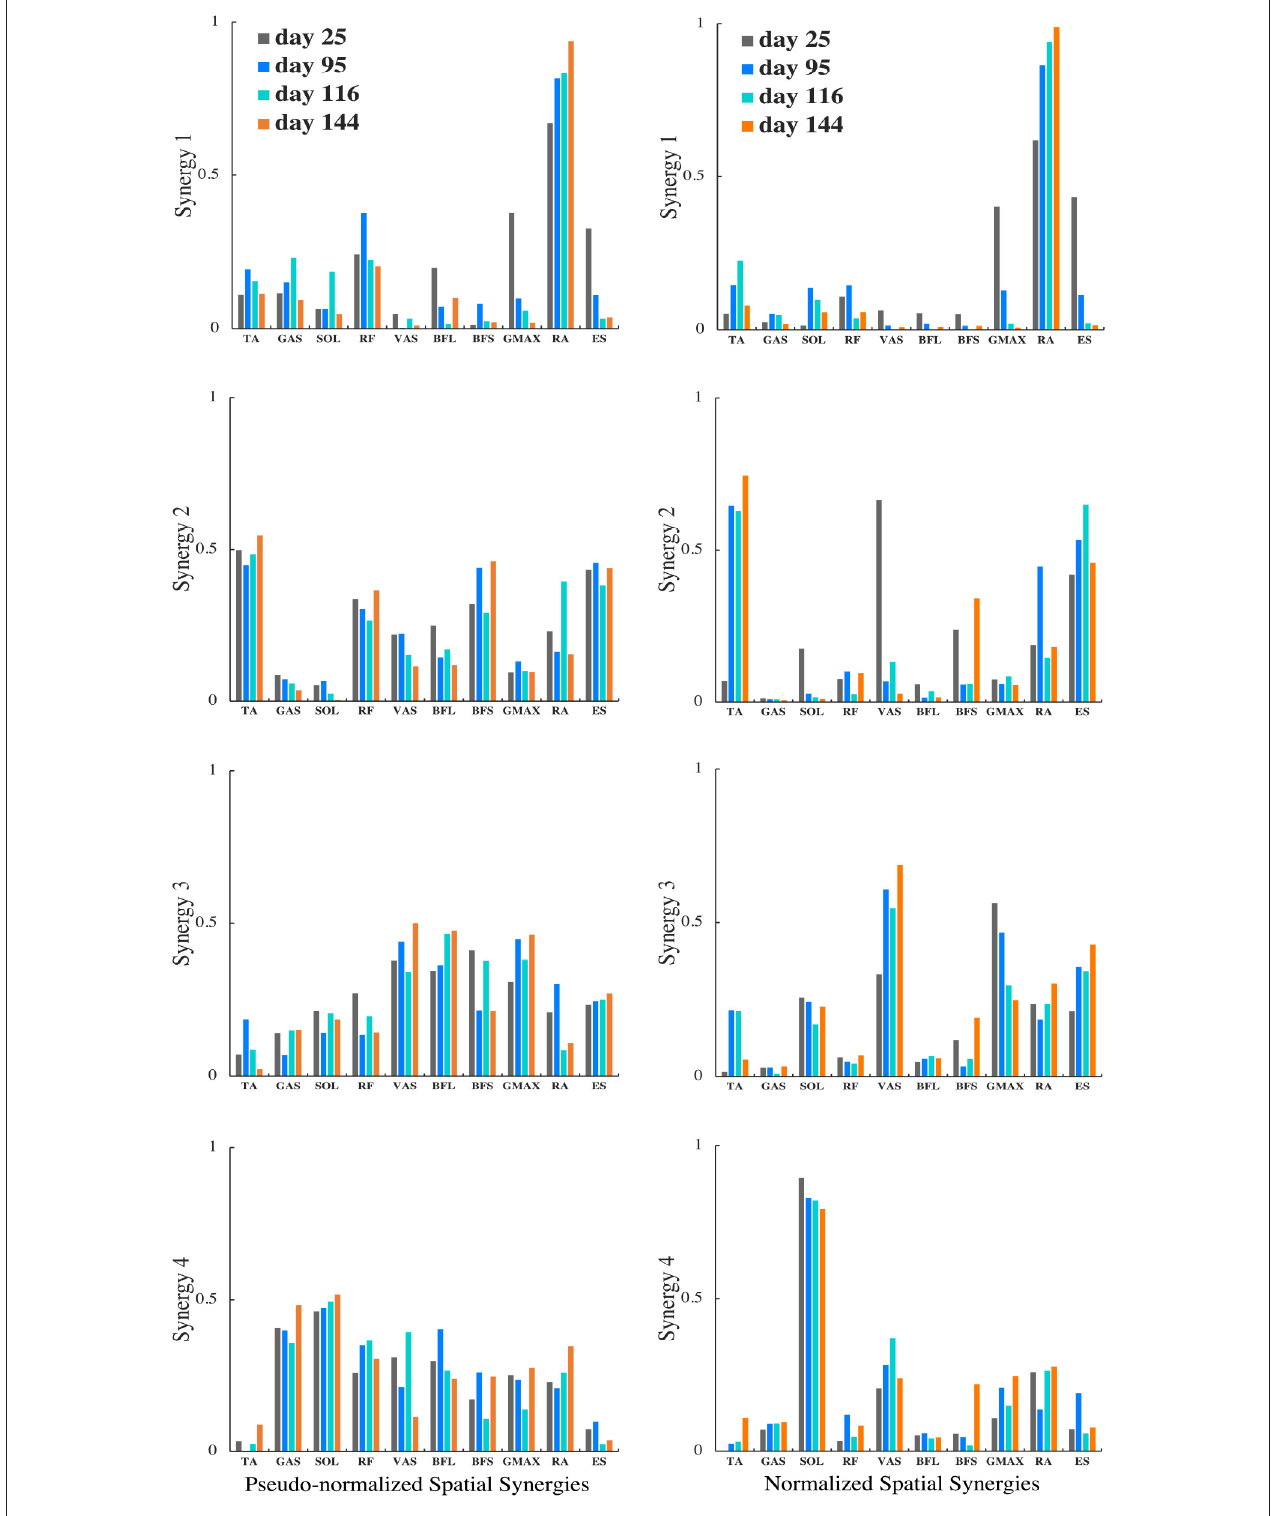
FIGURE 5 | Muscle synergy spatial patterns of the representative patient with +13 points of improvement in FMA score on the 25th, 95th, 116th, and 144th day after initial stroke onset. The left column shows spatial patterns of each synergy normalized by within-subject peak EMG, noted as pseudo-normalized for comparison. The right column shows spatial patterns of each synergy normalized by proposed method. Vertical axis indicates relative muscle activation levels ranging from 0 to 1. Horizontal axis presents muscle names.